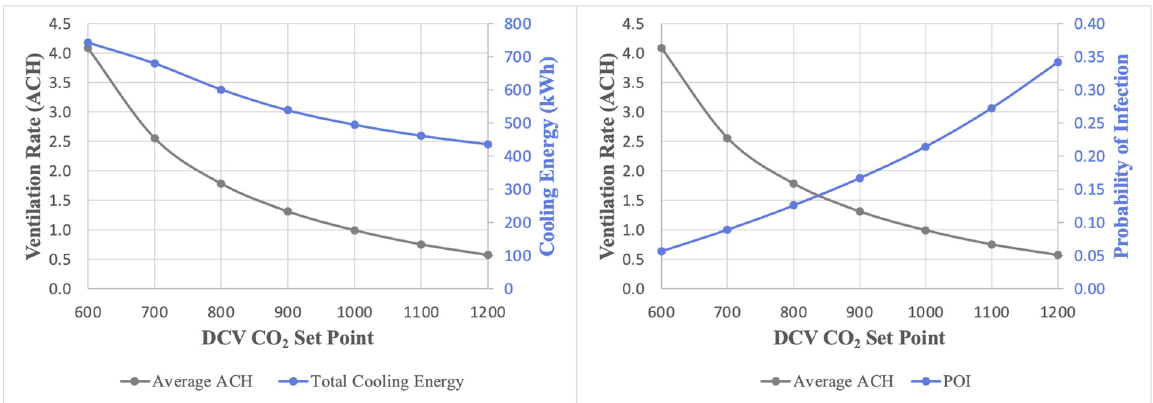
Figure 8. Impacts of DCV CO 2 set point on POI and cooling energy for July 22 nd .